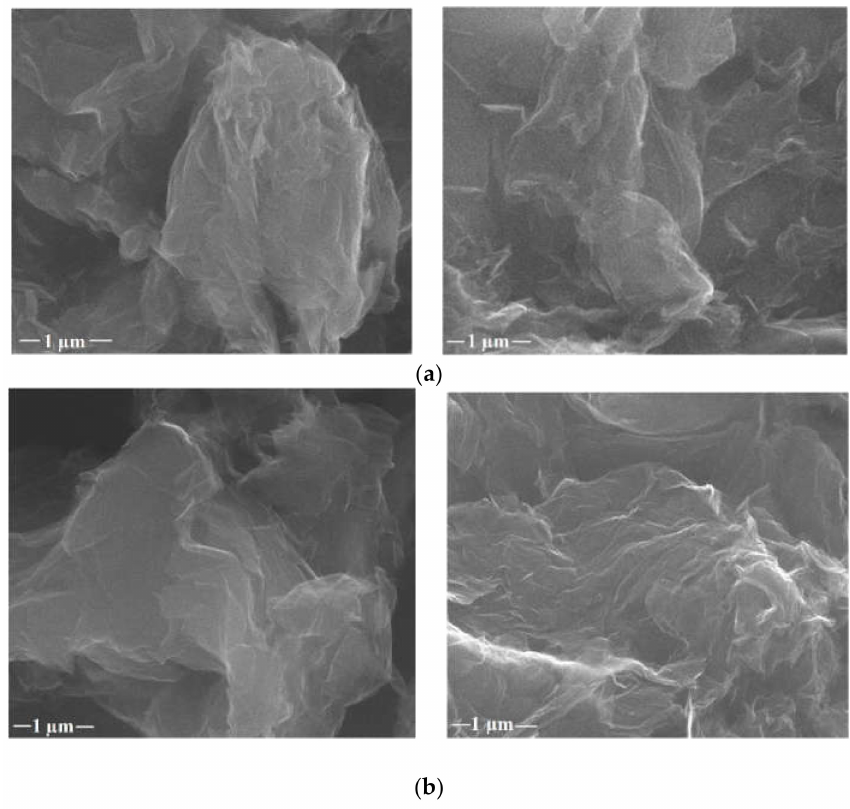
Figure 3. SEM images for ( a ) GOJu 10% ( w / v ) ( left ), GOJu 5% ( w / v ) ( right ), ( b ) GOQu 5% ( w / v ) ( left ), and GOQu 2.5% ( w / v ) ( right ) at 100,000 × mag.